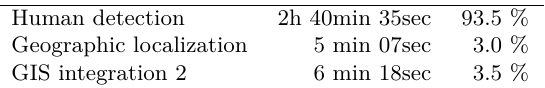
Table 2. Performance of Flight